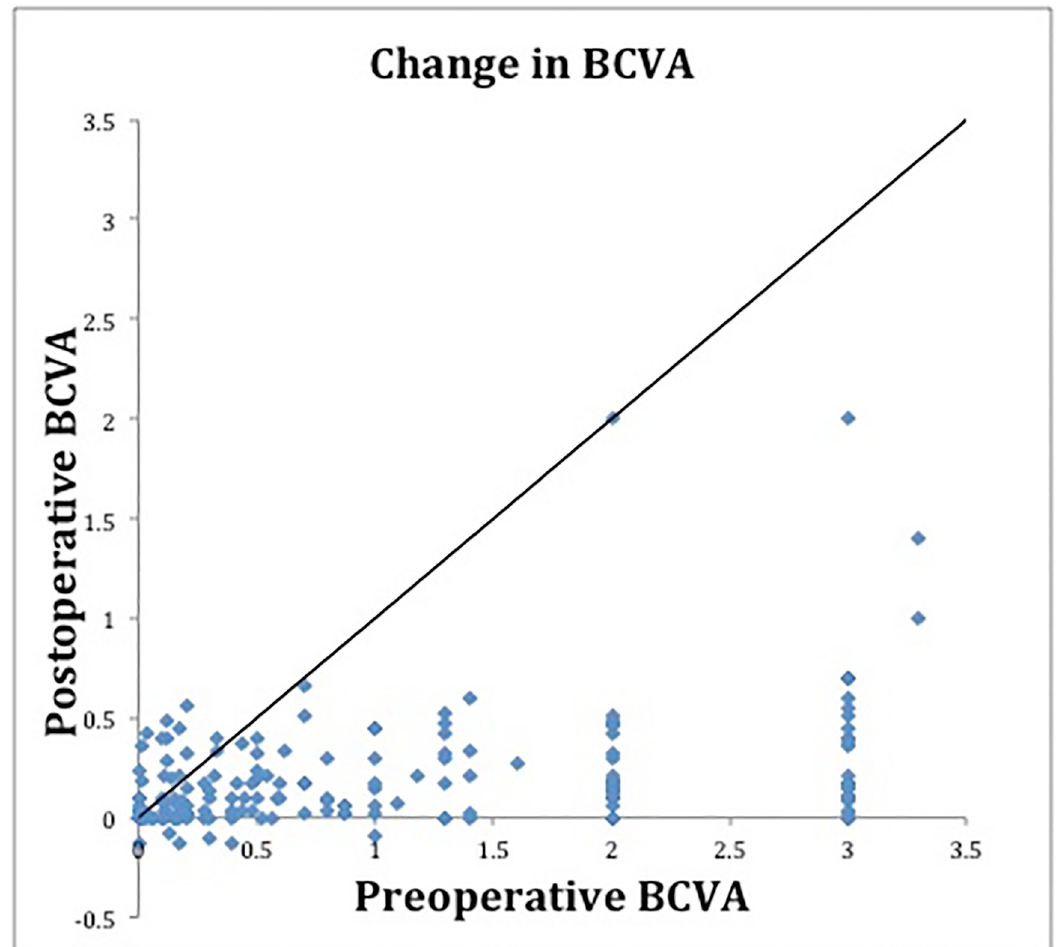
Fig 1. Change in visual acuity after surgical intervention. Scattergram showing the best-corrected visual acuity (BCVA, logarithm of the minimum angle of resolution unit) at last follow up as compared to day of presentation.